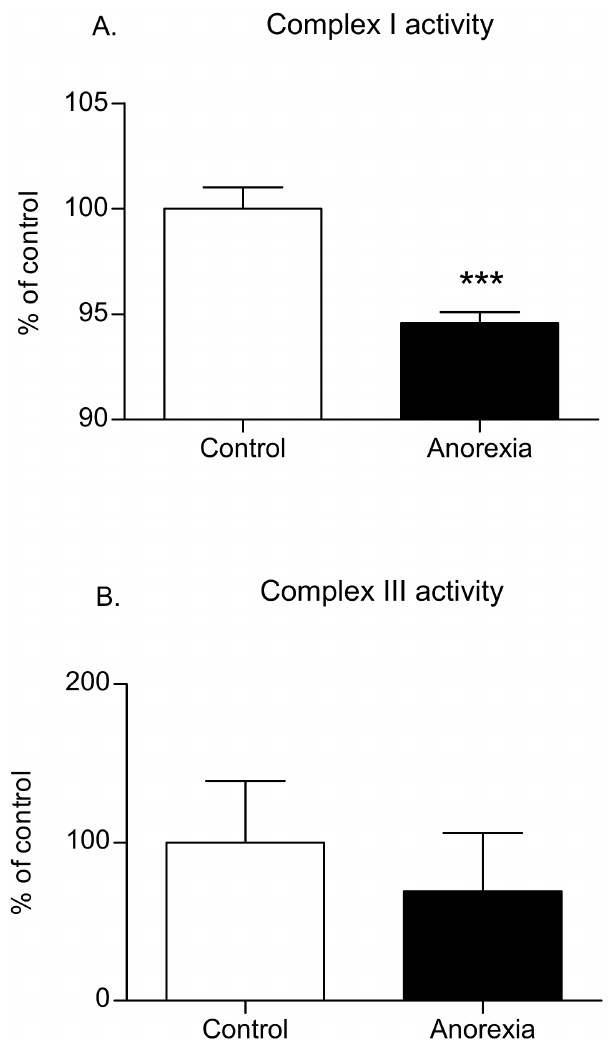
Figure 3. Effect of anorexia on mitochondrial complex I activity (A), measured as the NADH oxidation rate at 340 nm, and on complex III activity (B), measured as the cytochrome C reduction rate at 550 nm. Specific inhibitors for complexes I and III, rotenone and antimycin A, respectively, were employed to ensure the specificity of the assay. n=8 per group. ***P , 0.001 vs.